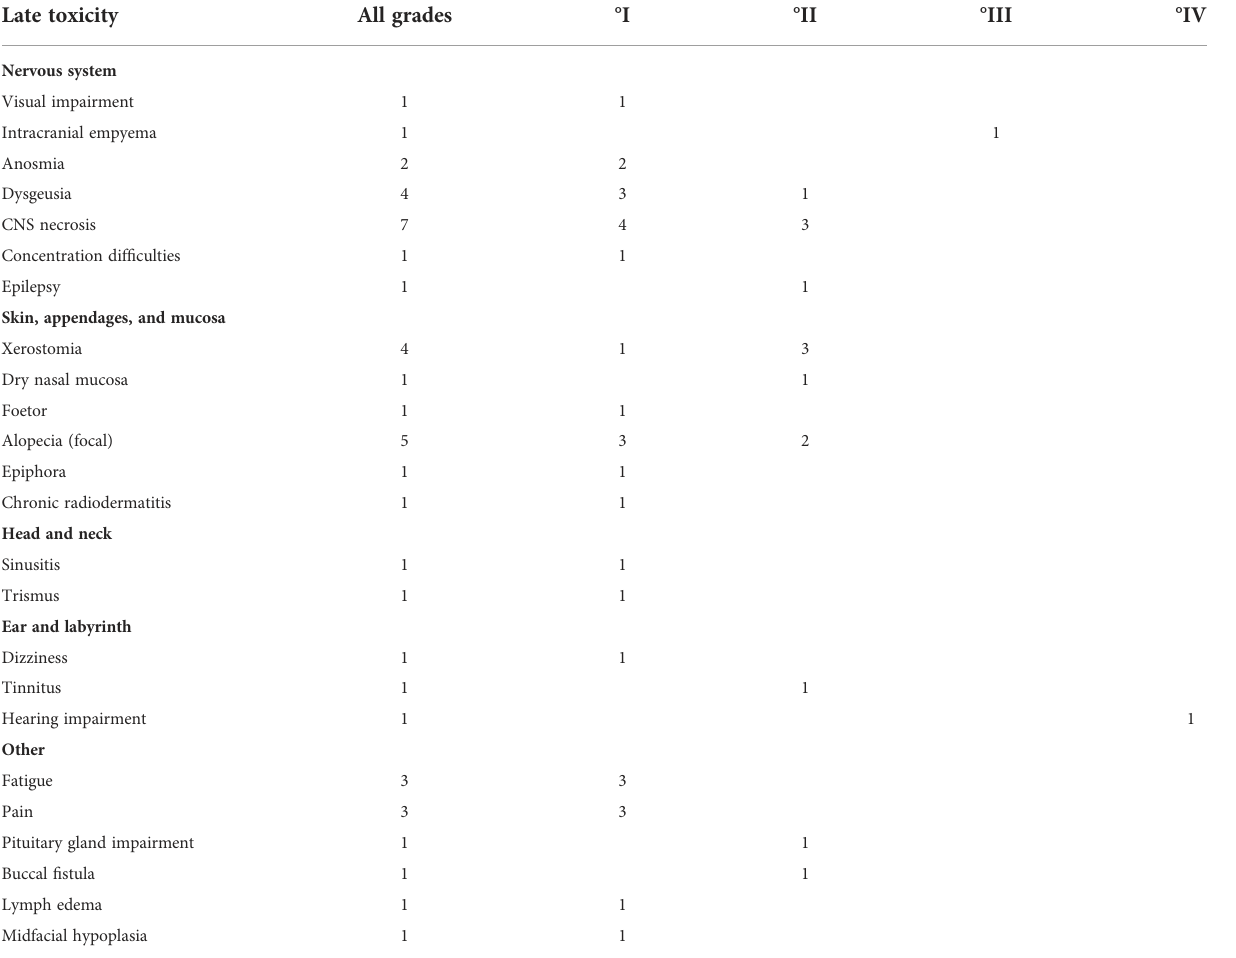
TABLE 4 Late toxicity of patients with craniofacial osteosarcoma (n =